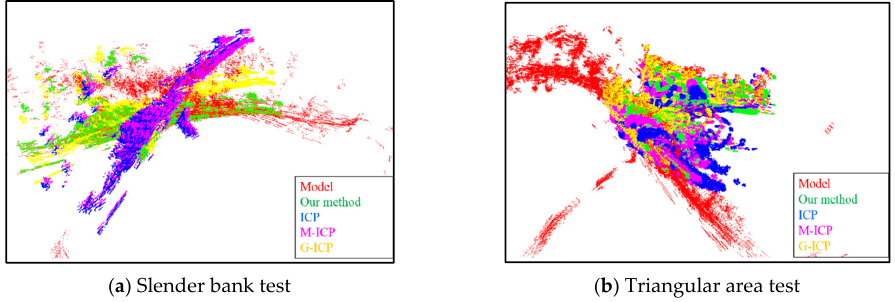
Figure 9. Registration results for the normal initial error test. In the slender bank test, the translation error was [5, 4, 4], and the rotation error was [17.1°, 20°, 34.2°], our proposed method make the registration with the RMS error at 1.1 m and rotation error at 1.5°. In the triangular area test, the translation error was [4, 3, 10], and the rotation error was [10°, 20°, 34.2°], our proposed method guarantee the registration result with the RMS error at 0.4 m and rotation error at 1.1°.